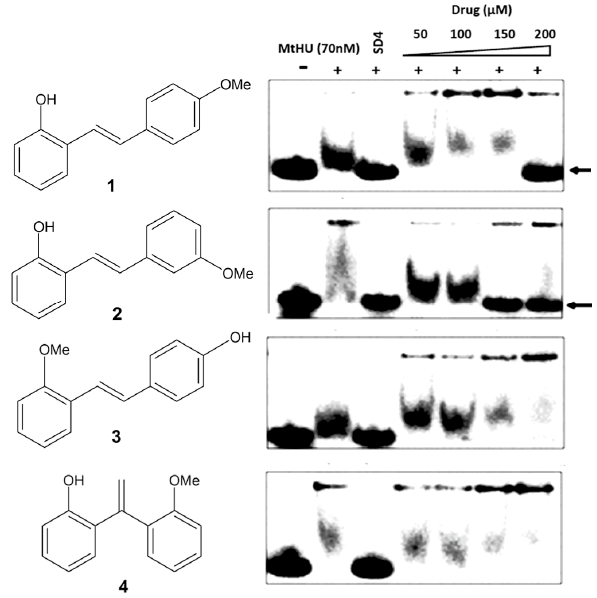
Figure 1. Chemical structures of the prepared diarylethenes 1 – 4 and their inhibition of Mycobacterium tuberculosis HU binding to DNA. Lane − is for pure protein and lane + is for the mixture of HU and DNA showing complex formation. SD4 is an experimental HU inhibitor [8] used a positive control at 5 µM concentration.